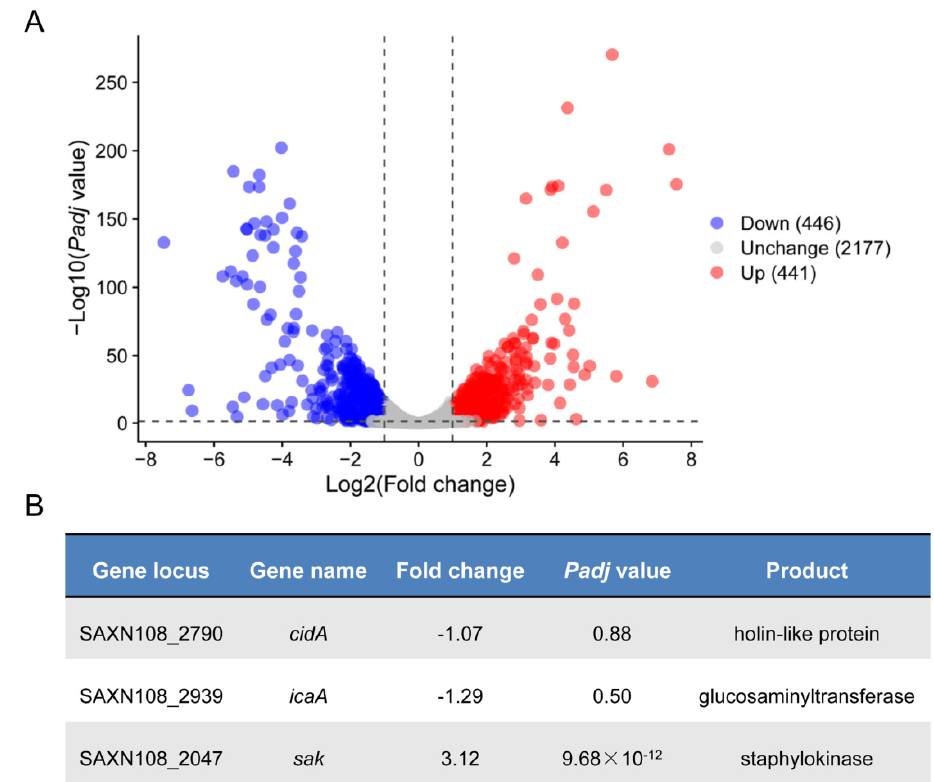
Figure 2. Gene expression analysis of S. aureus strain XN108 and mutant ∆ ccpA . ( A ) The volcano plot of gene expression profiles revealed by RNA-seq. Downregulated differentially expressed genes (DEGs) were labeled with a blue circle, upregulated DEGs with red, and unchanged genes with gray. ( B ) Expression characteristics of selected